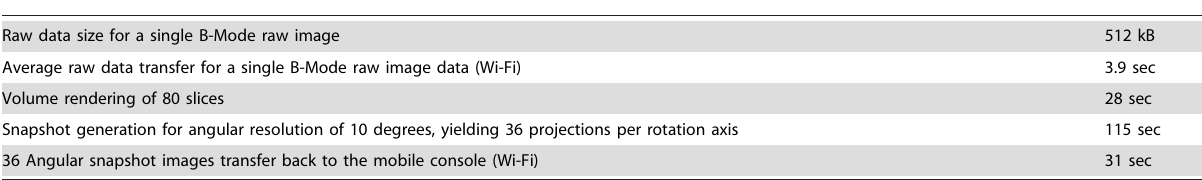
Table 1. Performances measurements.